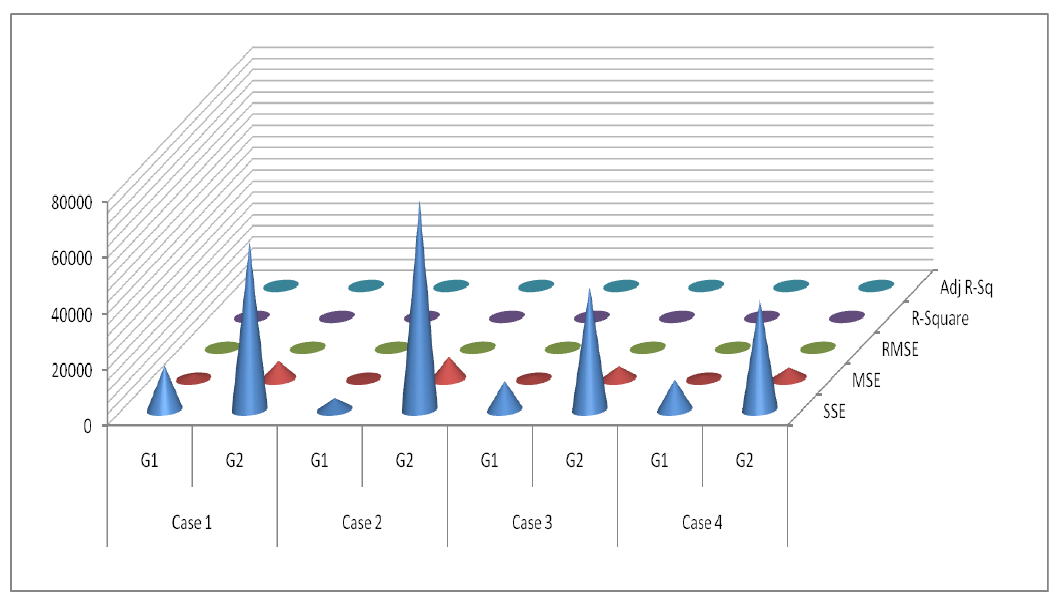
Fig. 5. Comparison criterions for all